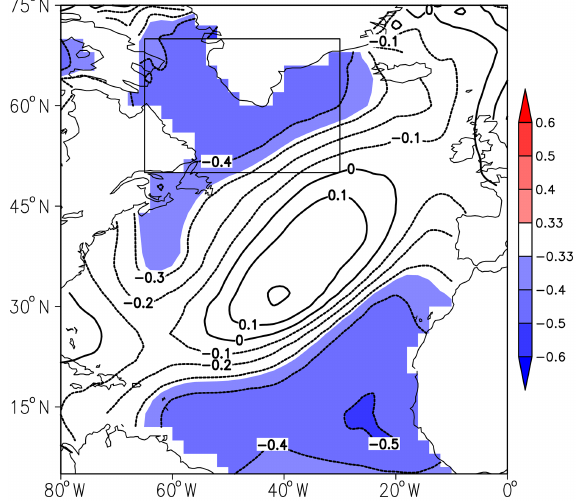
Figure 6. The CC between WHD NCP DY and Atlantic SST DY in autumn from 1980 to 2013. The shades indicate that the CC ex- ceeded the 95% confidence level, and the rectangle represents the selected region (50–70 ◦ N, 30–65 ◦ W) of predictor x 3